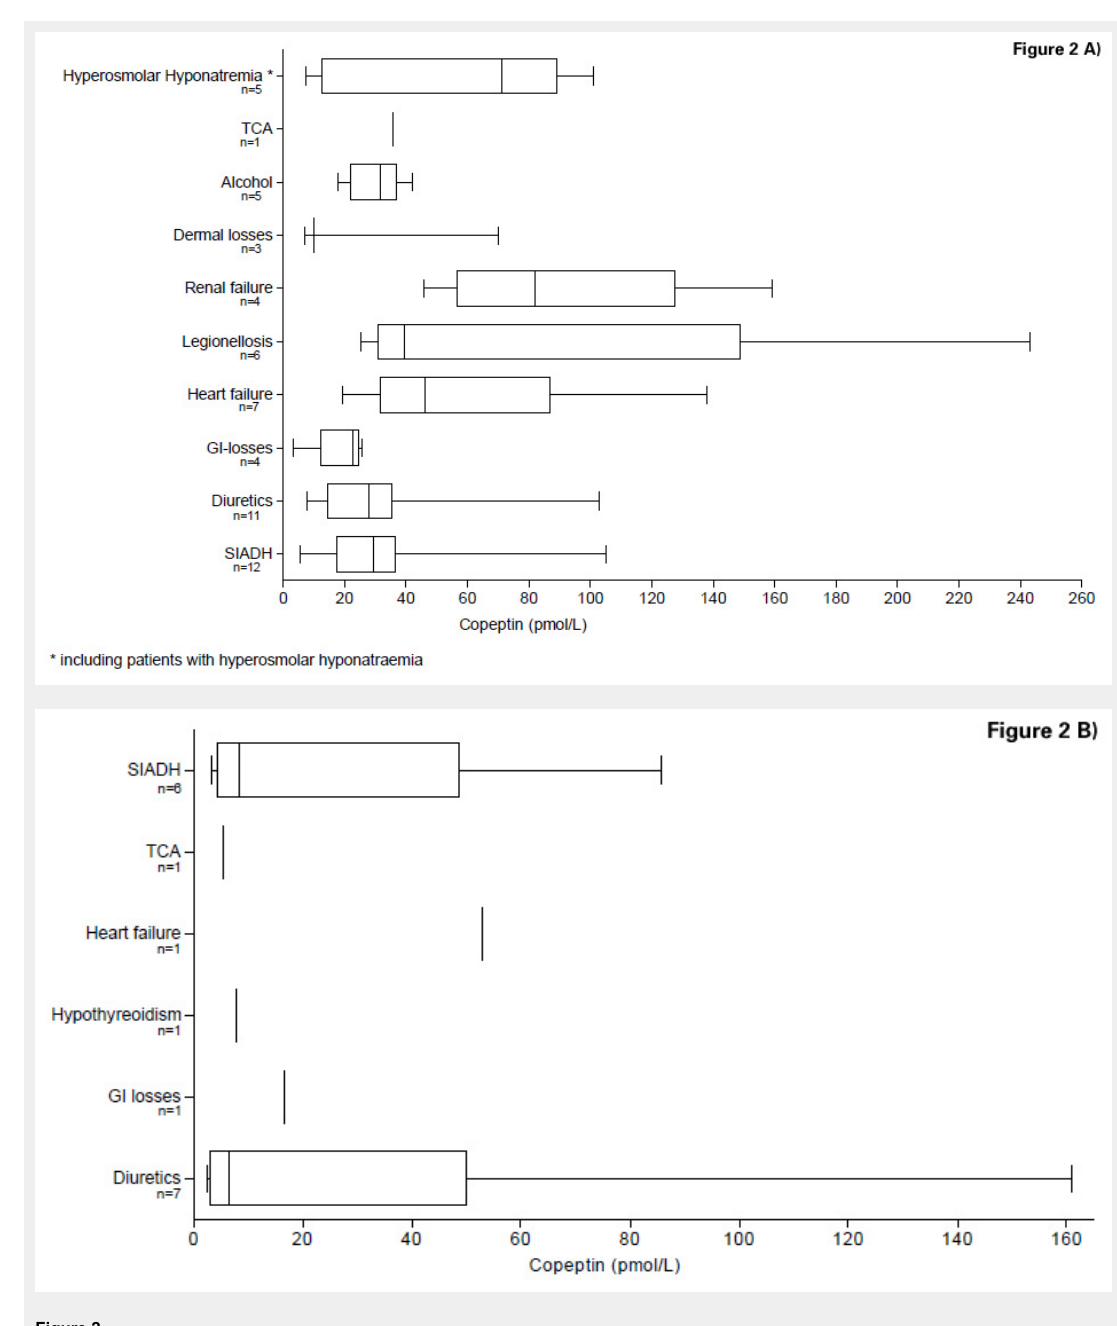
Figure 2 A) Copeptin levels in the differential diagnosis of hypoosmolar and hyperosmolar hyponatraemia (Study A/B) B) Copeptin levels in the differential diagnosis of hypoosmolar hyponatraemia (Study